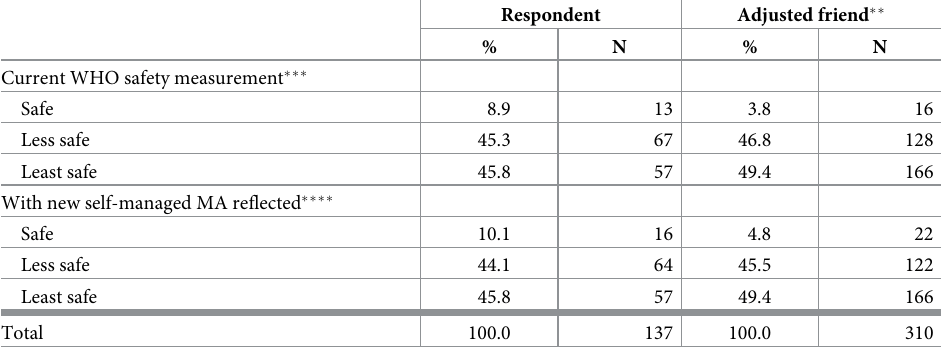
� Bolding indicates statistically significantly different at the p < 0.05 level (reference respondent) �� Adjusted friend data includes respondent abortion details for respondents who reported having no friends ��� Surgery and medication abortion from clinical source = safe ���� Surgery from facility and medication from any source =